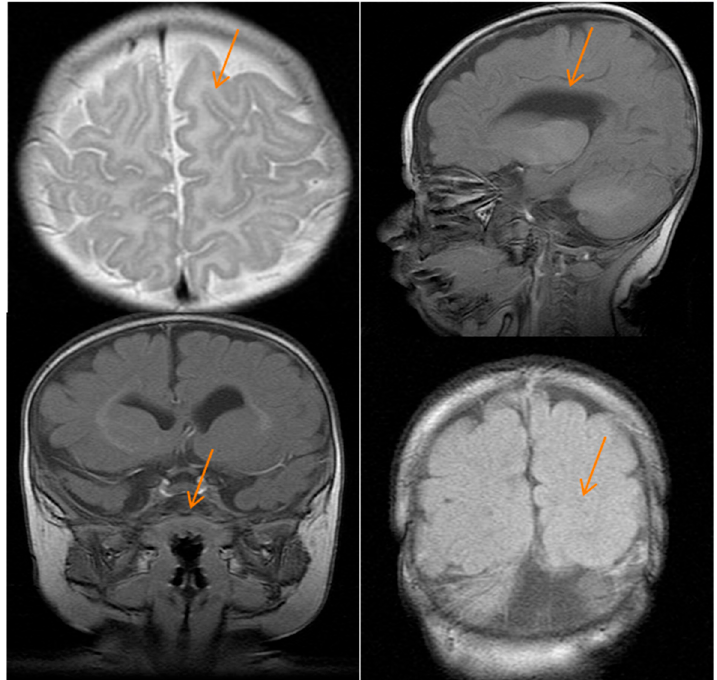
Figure 2. Brain magnetic resonance imaging of the patient. Images show cortical dysgenesis ( top left and lower right figures), a thin corpus callosum ( top right figure), and hypoplastic pons ( lower left figure); the red arrows indicate the brain defects.